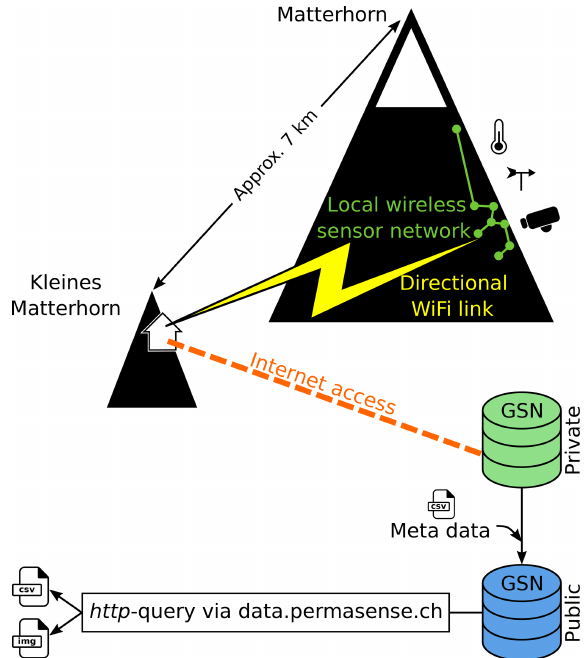
Figure 4. System architecture: data are collected with a local wire- less sensor network and transmitted to the summit station of Kleines Matterhorn. The private GSN server receives the data, which are stored in a primary database. Data are passed on to a public GSN server where they are mapped to metadata (positions, sensor types, calibration, etc.) and converted to convenient data formats. Finally, data are available for download and analysis using external